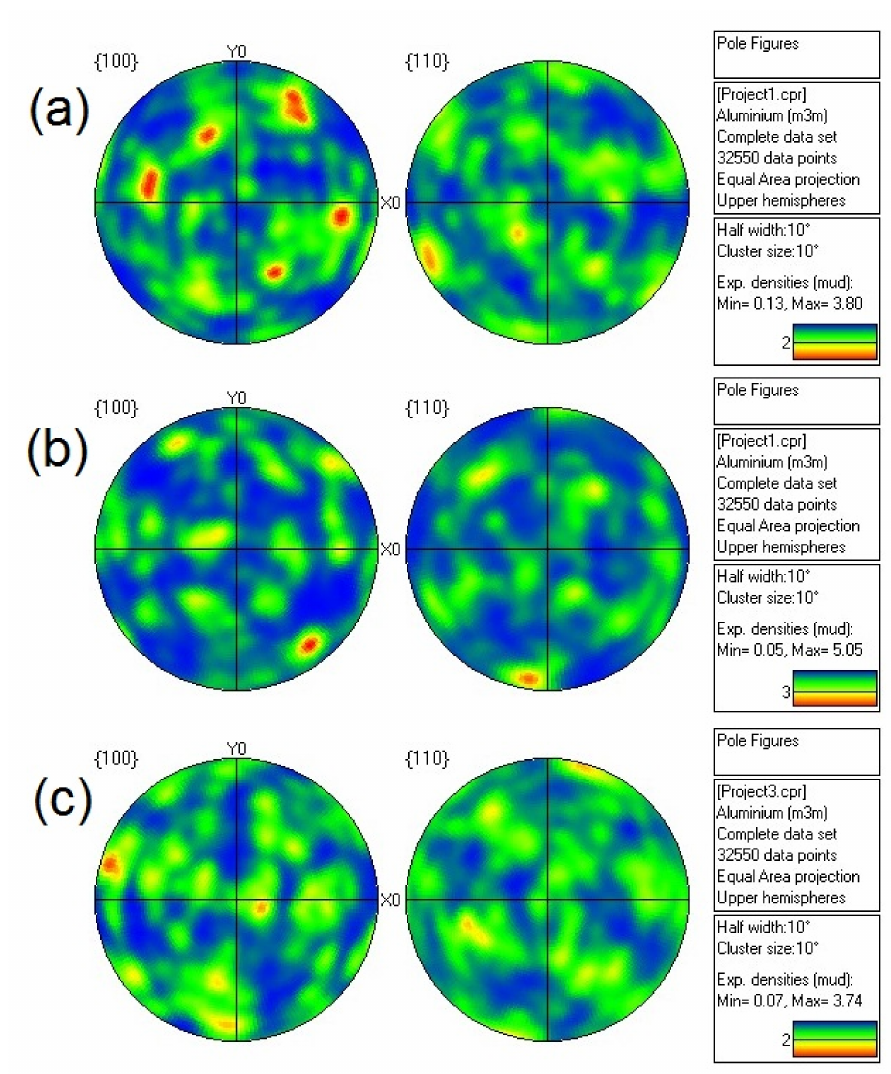
Figure 4. {100} and {110} pole figures of the Al/1 wt% CNT composites after ( a ) 20%, ( b ) 45%, and ( c ) 90% of thickness